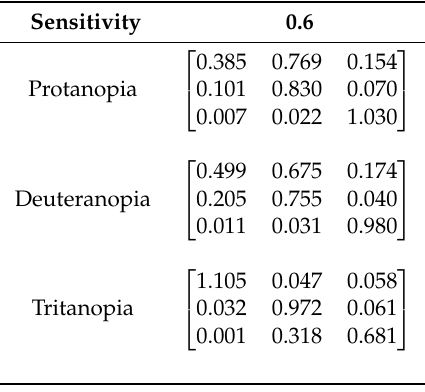
Figure 4. The three types of color vision deficiency simulation using Machado’s approach [35] with sensitive 0.6 and the matrix Φ CVD as shown in Table 3. Table 3. Machado’s Simulation Matrices Φ CVD